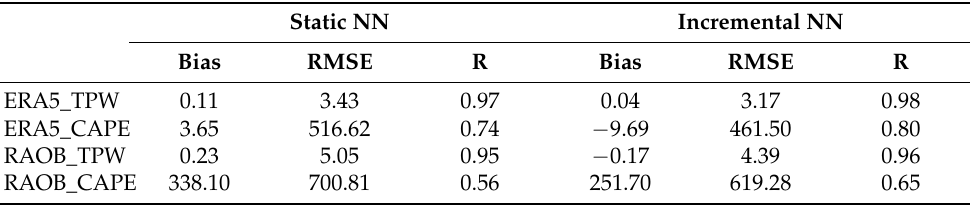
Table 4. Accuracy assessment based on ERA5 and RAOB for the ST and INC NN model in the ELA region during the test period. Evaluation metrics (i.e., bias, RMSE, and R) are calculated. Static NN Incremental NN Bias RMSE R Bias RMSE R ERA5_TPW 0.11 3.43 0.97 0.04 3.17 0.98 ERA5_CAPE 3.65 516.62 − 9.69 RAOB_CAPE 338.10 700.81 251.70 619.28